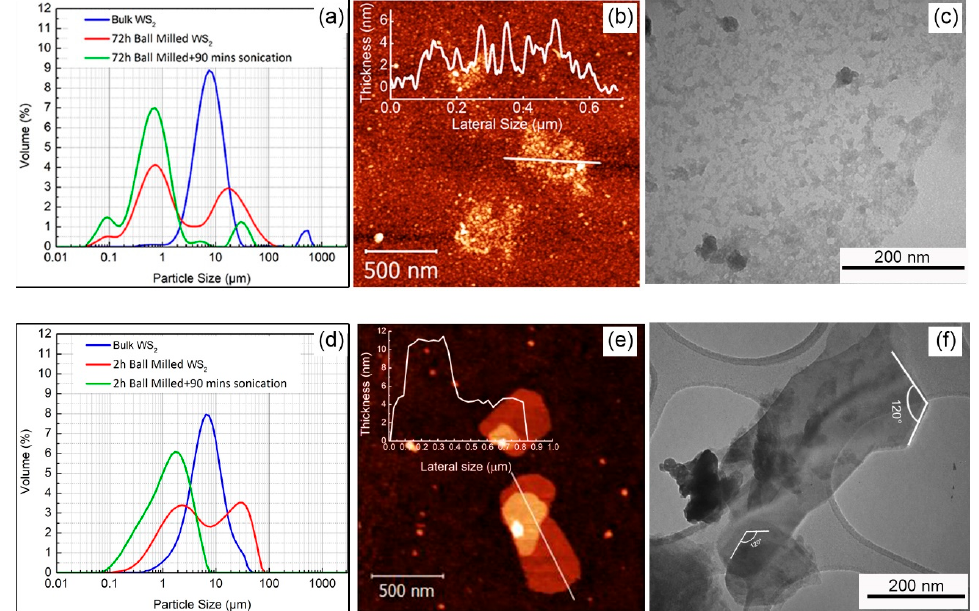
Figure 1. Comparison of the effect of long-time ball milling on WS 2 exfoliation: ( a ) Comparison of the particle size distribution of the starting WS 2 commercial powder (blue), 72 h ball milled (red) and 72 h ball milled and 90 min sonicated (green), ( b ) AFM picture of 72 h ball milled and 90 min sonicated and associated thickness profile along the white line, ( c ) TEM picture of the 72 h ball milled and 90 min sonicated WS 2 , ( d ) Comparison of the particle size distribution in case of 2 h ball milling, ( e ) AFM picture of 2 h ball milled and 90 min sonicated and associated thickness profile, ( f ) TEM picture of the flakes obtained by 2 h ball milling and 90 min sonication of WS 2 .